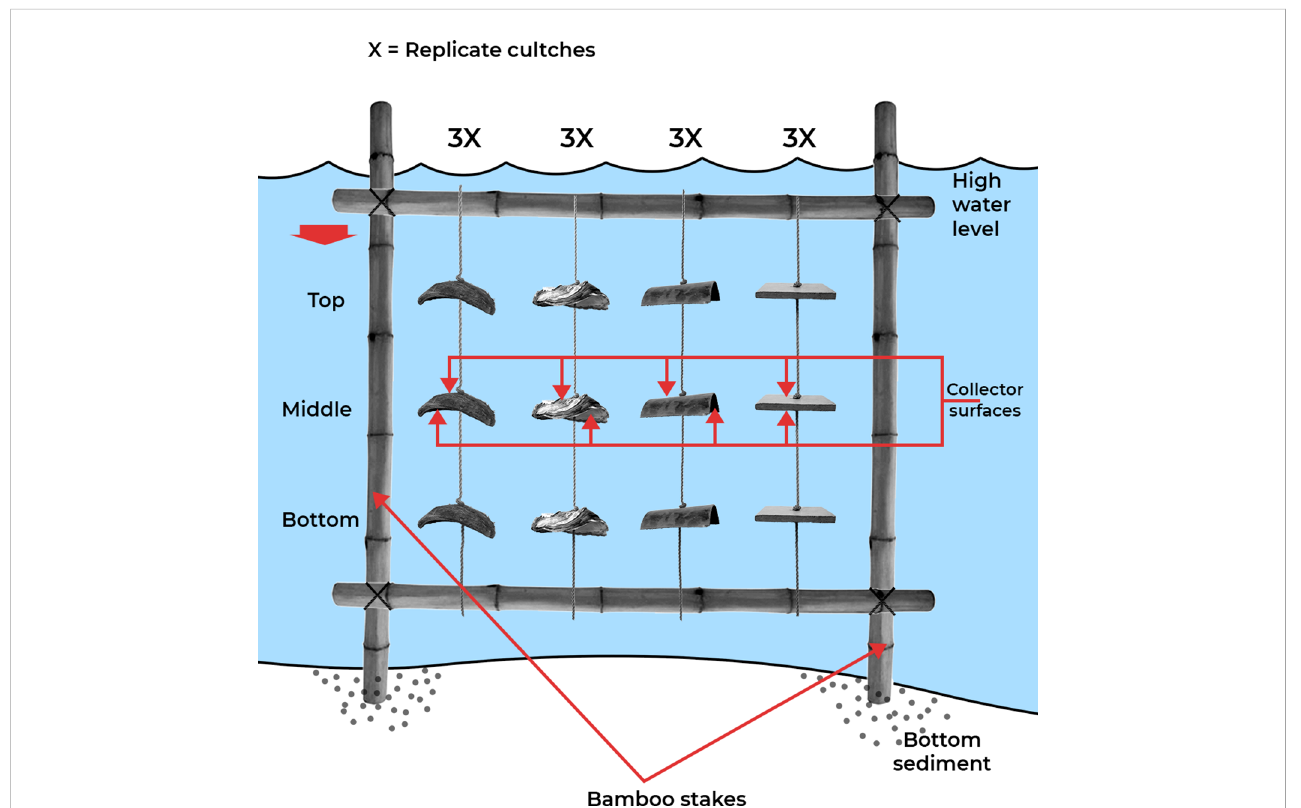
FIGURE 2 An illustration of the cross-sectional view of the experimental setup at each station (not to